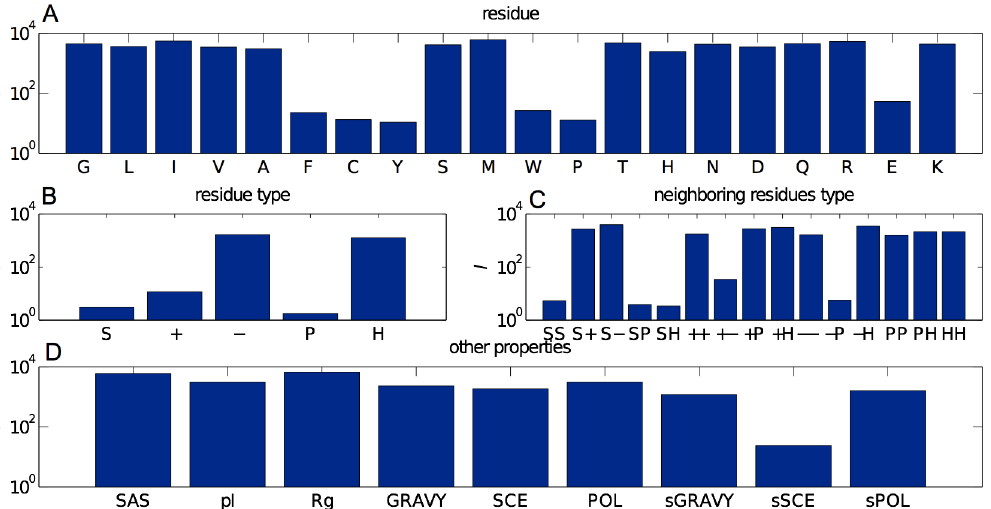
Figure 4. Length scales l associated with the parameters for the maximal log-likelihood model (highest point in Fig. 2 A). The plots divide the explanatory variables in (A) residues, (B) residue type (small S, positively charged + , negatively charged { , polar P and hydrophobic H), (C) neighboring residue type (pairs of these symbols), and (D) other global protein properties (see Methods for details).